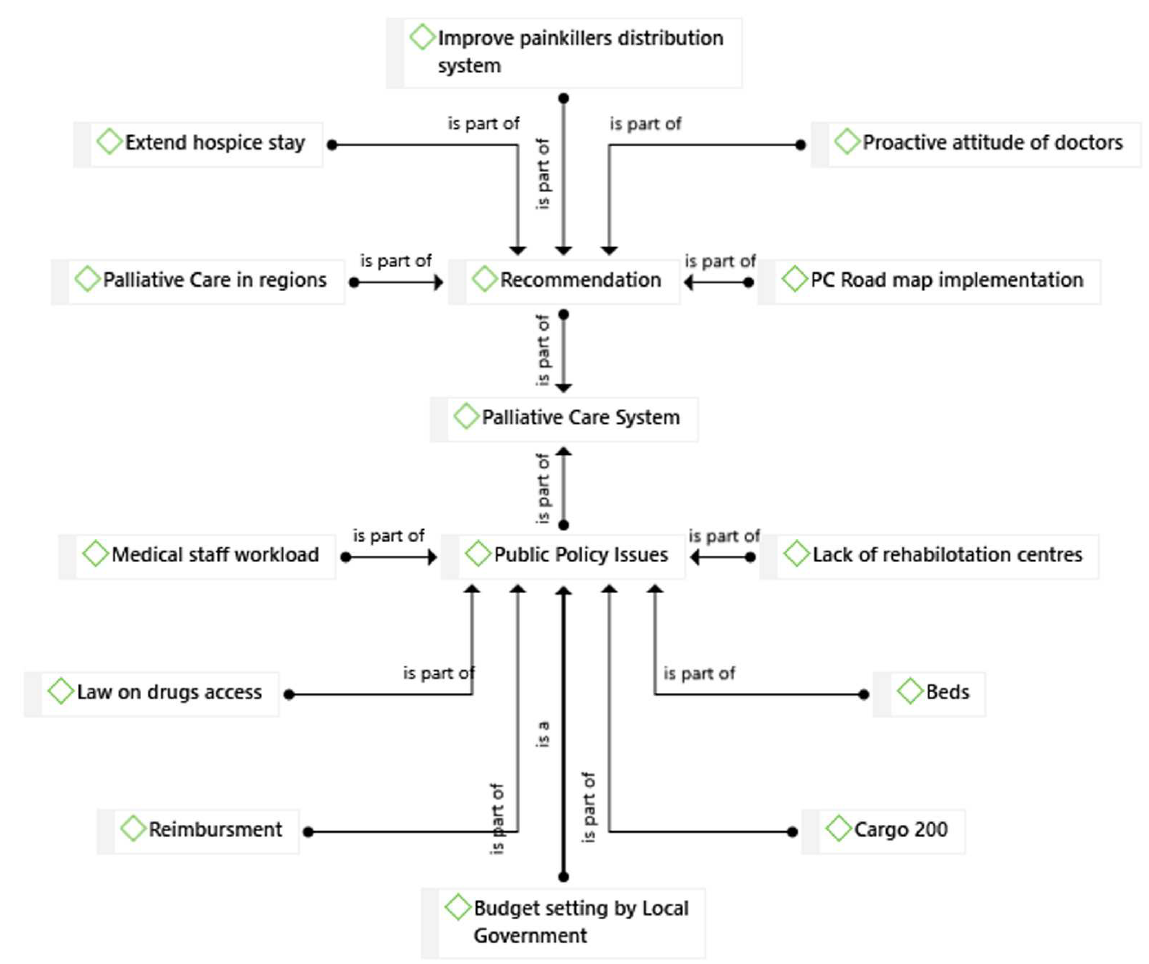
Figure 3. Public policy issues and